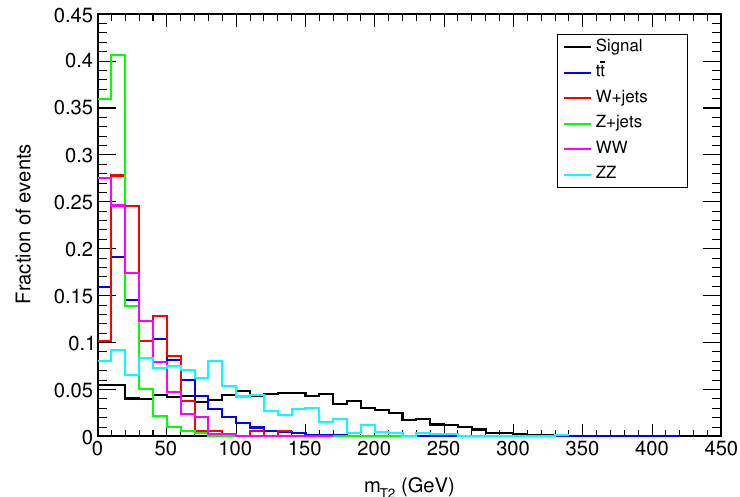
Figure 1 . Distribution of the m T 2 variable for the signal and the main backgrounds after requiring exactly two opposite-sign tau leptons in the event that pass the selection